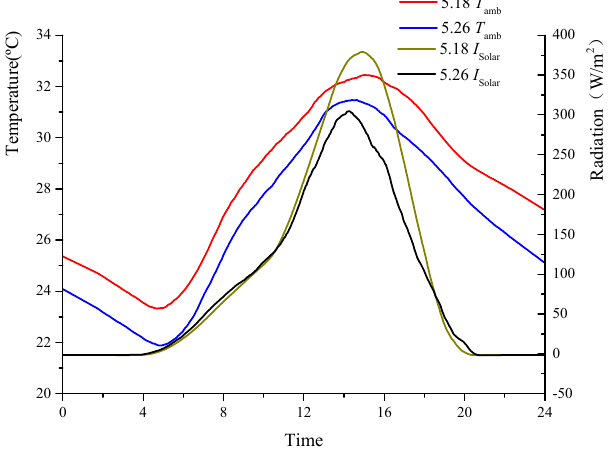
Figure 6. Ambient parameter comparison between 18 and 26 May (solid wall test system). Energies 2017 , 10 , 1878